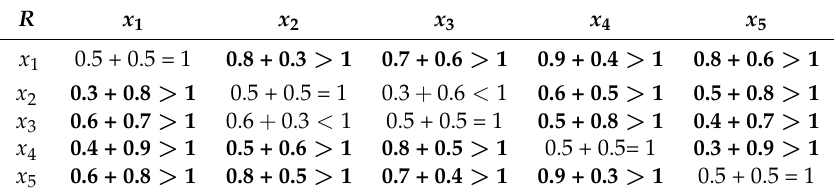
Table 1. Checking intuitionistic fuzzy sets (IFSs) requirement to address the